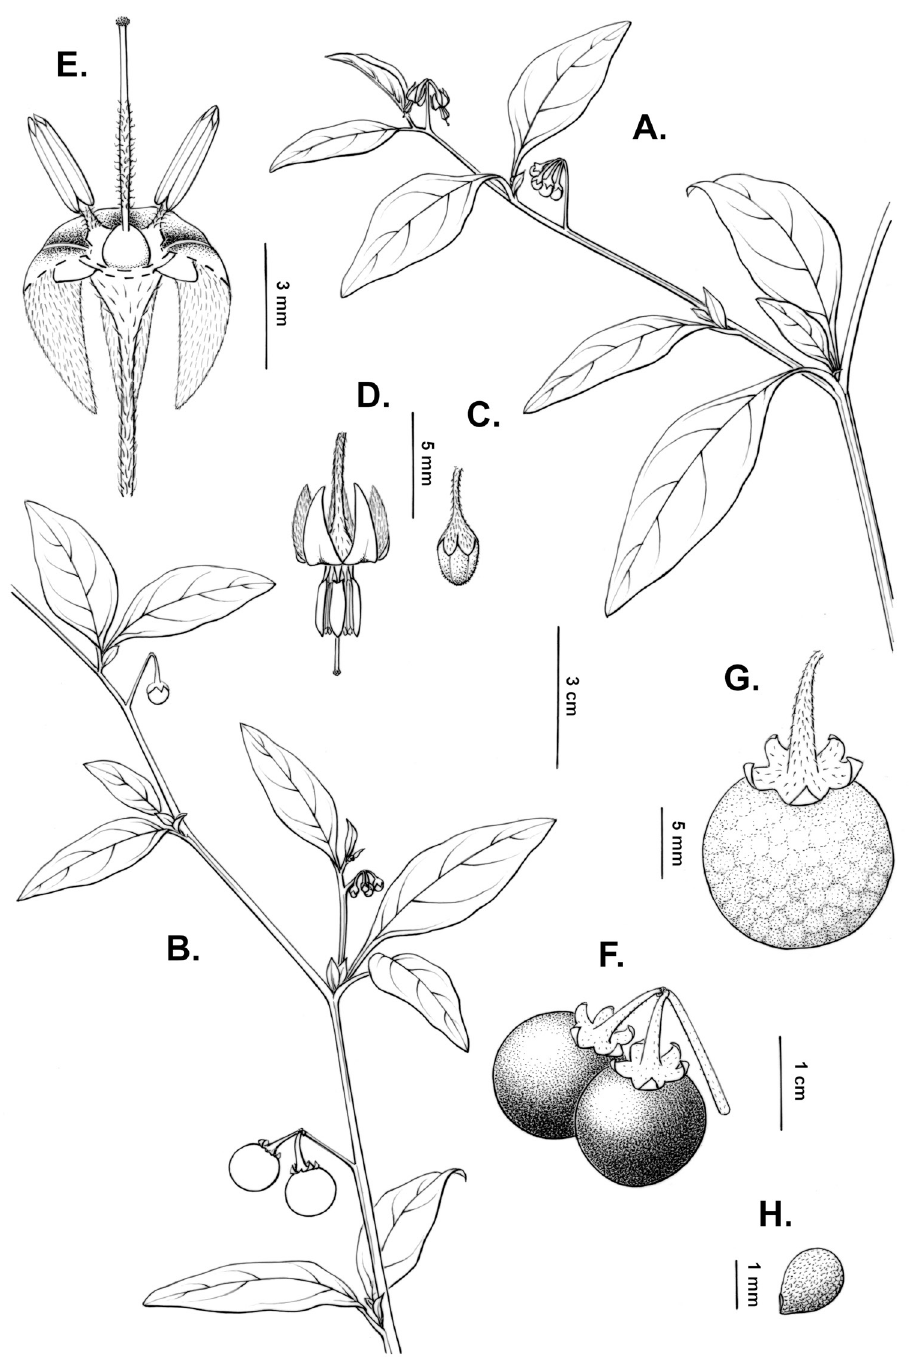
Figure 39. Solanum pseudogracile Heiser. A Habit B fruiting habit C bud D flower E dissected flower F mature fruits G dried berry H seed ( A–H Kearney 1250 ). Drawing by C.